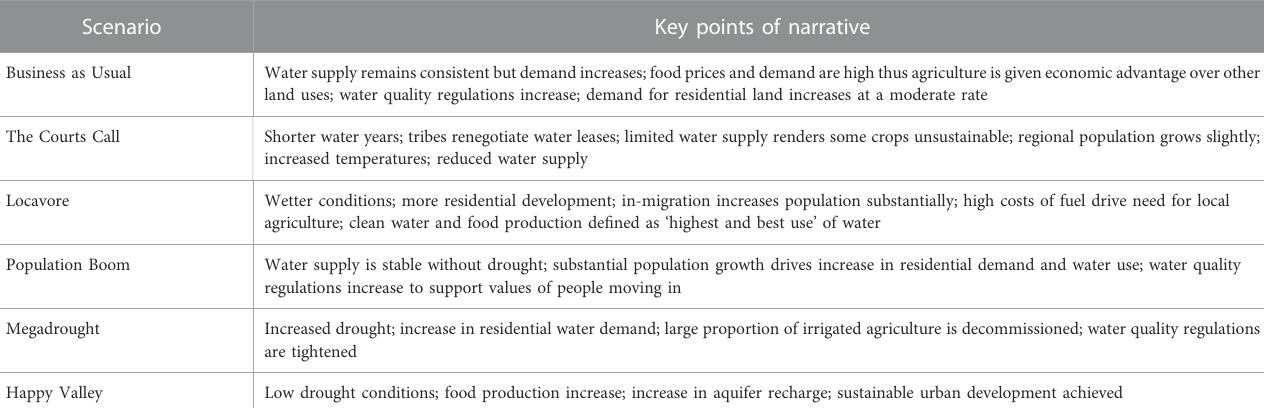
TABLE 1 Summary narratives for the six scenarios co-developed with the stakeholder advisory group for the Magic Valley, Idaho (based on Cronan et al., 2022b). Scenario Key points of